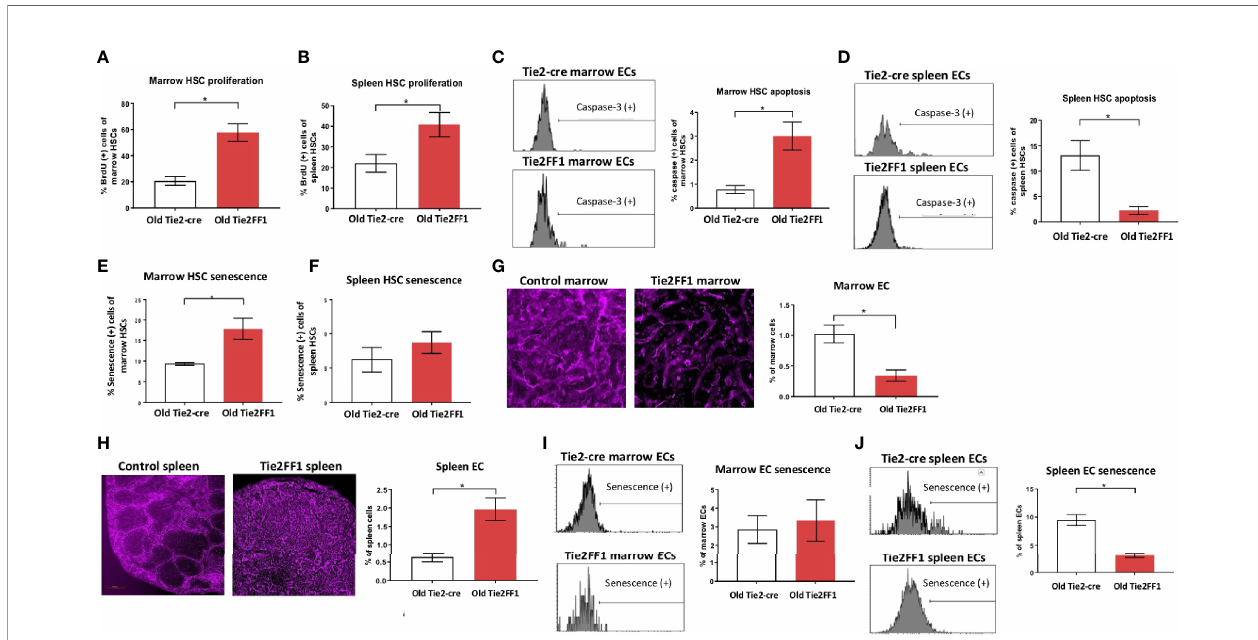
FIGURE 4 | Different HSC functions in the marrow and spleen of old Tie2FF1 mice (A, B) Cell proliferation rate of HSCs in the marrow (A) and spleen (B) measured by in vivo BrdU labeling (A: n=4-5 mice in each group; B: n=4 mice in each group). (C, D) Representative fl ow cytometry histograms (left) and quantitative analysis of cellular apoptosis rate of HSCs in the marrow (C) and spleen (D) measured by activated caspase-3 staining using fl ow cytometry analysis ( C : n=5 mice in each group; D : n=5-6 mice in each group). (E, F) Cellular senescence rate of HSCs in the marrow (E) and spleen (F) measured by SA- b -Gal activity using fl ow cytometry analysis (E) : n=5 mice in each group; (F) n=5-6 mice in each group). (G, H) Representative immuno fl uorescent images of VE cadherin (+) vasculatures (magni fi cation 1Ox for femur marrow and 4x for spleen) (left) and fl ow cytometry quantitative analysis of CD45 - CD31 + ECs (right) of the marrow (G) and spleen (H) from 18mo Tie2- cre control and Tie2FF1 mice (G) : n=8 mice in each group; (H) n=5 mice in each group). (I) Representative fl ow cytometry histograms (left) and quantitative analysis of cellular senescence of marrow ECs (n=4 mice in each group). (J) Representative fl ow cytometry histograms (left) and quantitative analysis of cellular senescence of spleen ECs (n=3 mice in each group).* P <